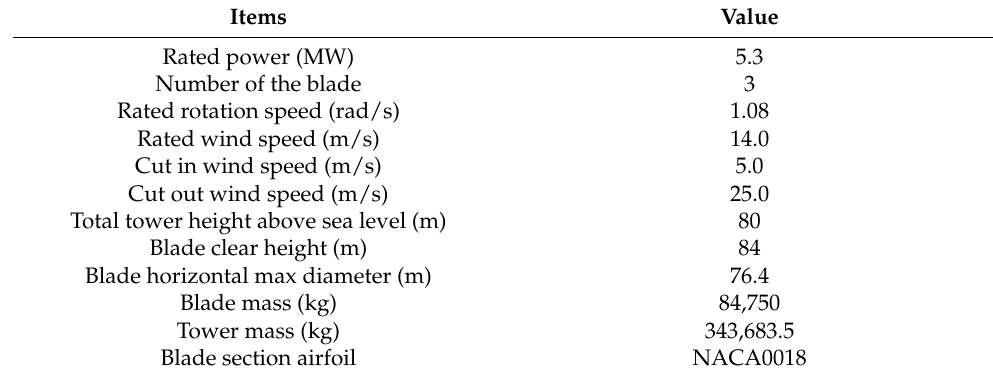
Table 1. Parameters of the wind turbine.